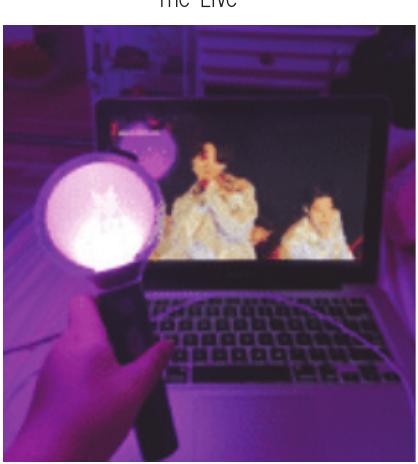
<Figure 6> Lightick during “BangBangCon: The Live”